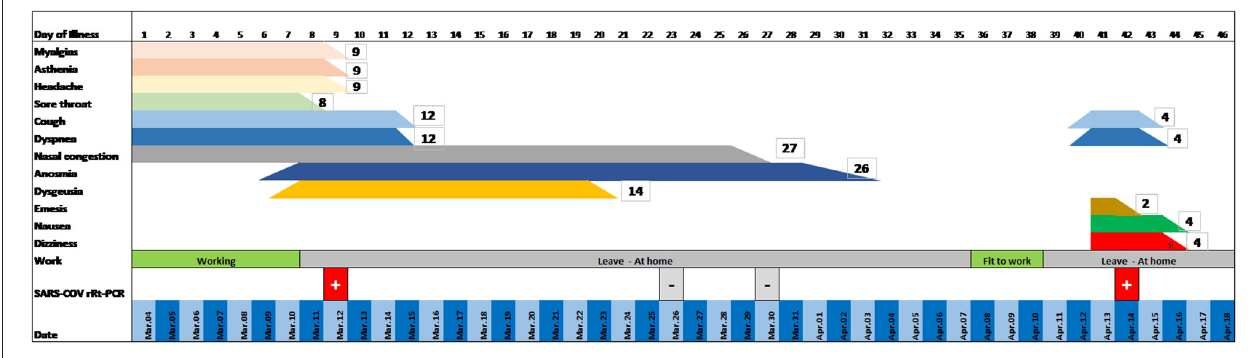
FIGURE 1 | Clinical evolution of the patient: